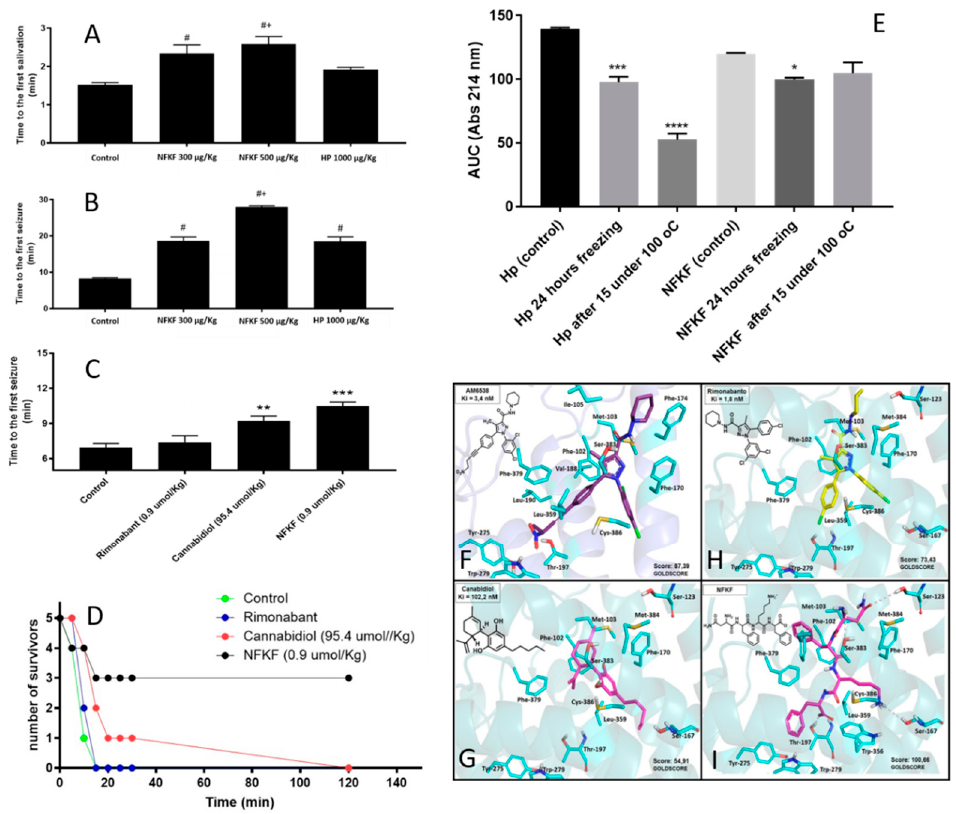
Figure 1. Pharmacological and molecular characterization of cannabinoids in cannabinoid type 1 G-